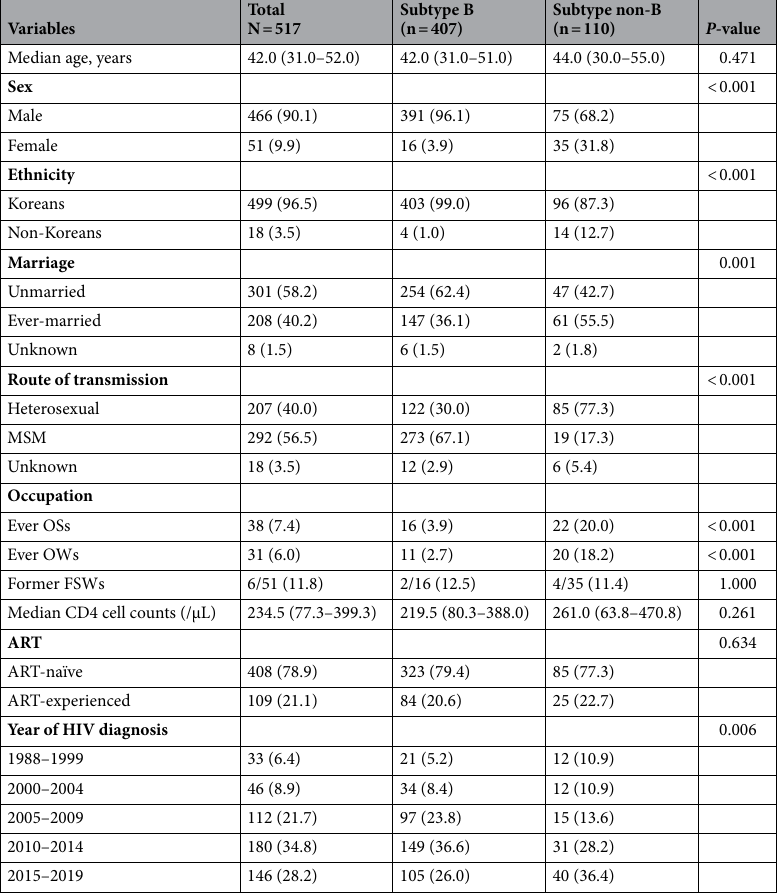
Table 1. Demographic and clinical characteristics of the study population according to the B/Non-B subtype. Values are expressed as number (%) or number (IQR). HIV human immunodeficiency virus, MSM